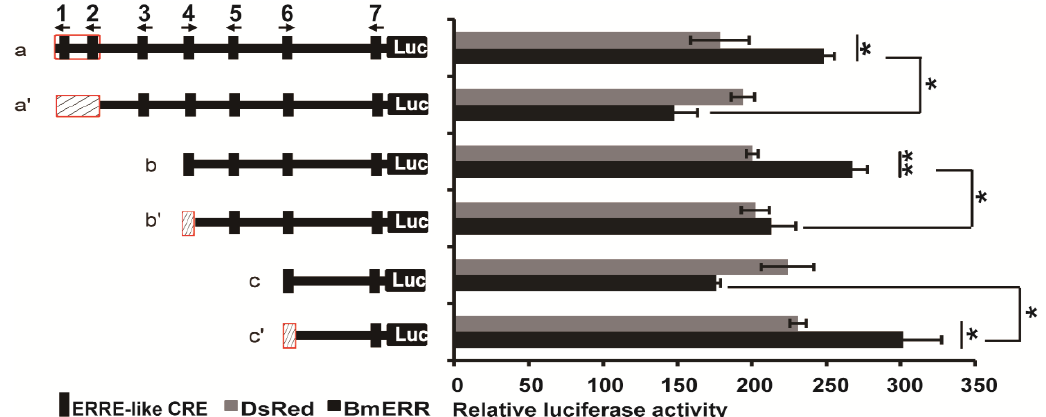
Figure 4. BmERR increased the activity of BmTreh promoter through core response elements — ERRE-like CRE 1,2,4 and 6 in embryonic silkworm cells. The significant difference between data sets was calculated using two-tailed Student ’ s t -tests; * p < 0.05. ** p < 0.01, NS: No significant difference.